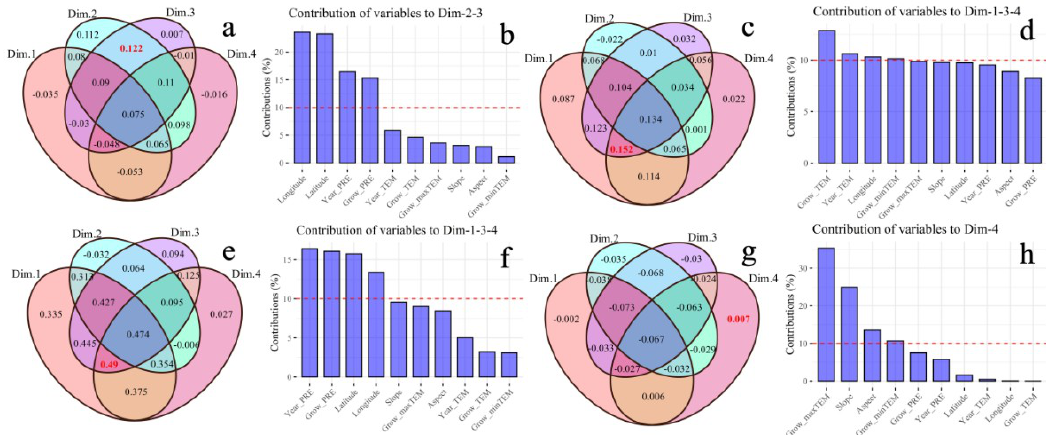
Figure 10. Interaction of driving factors based on multiple linear regression and principal component analysis for the alpine timberline and the contribution of driving factors to the principal components on different hillsides: ( a ) R 2 value of multiple linear regression of principal components to the nearest alpine timberline on the first hillside; ( b ) contribution of driving factors to Dim.2 and Dim.3 on the first hillside; ( c ) R 2 value of the multiple linear regression of principal components to the nearest alpine timberline on the second hillside; ( d ) contribution of driving factors to Dim.1, Dim.3, and Dim.4 on the second hillside; ( e ) R 2 value of the multiple linear regression of principal components to the nearest alpine timberline on the third hillside; ( f ) contribution of driving factors to Dim.1, Dim.3, and Dim.4 on the third hillside; ( g ) R 2 value of the multiple linear regression of principal components to the nearest alpine timberline on the fourth hillside; ( h ) contribution of driving factors to Dim.4 on the fourth hillside. Note: Dim1, Dim2, Dim3, and Dim4 are the first, second, third, and fourth principal component, respectively.